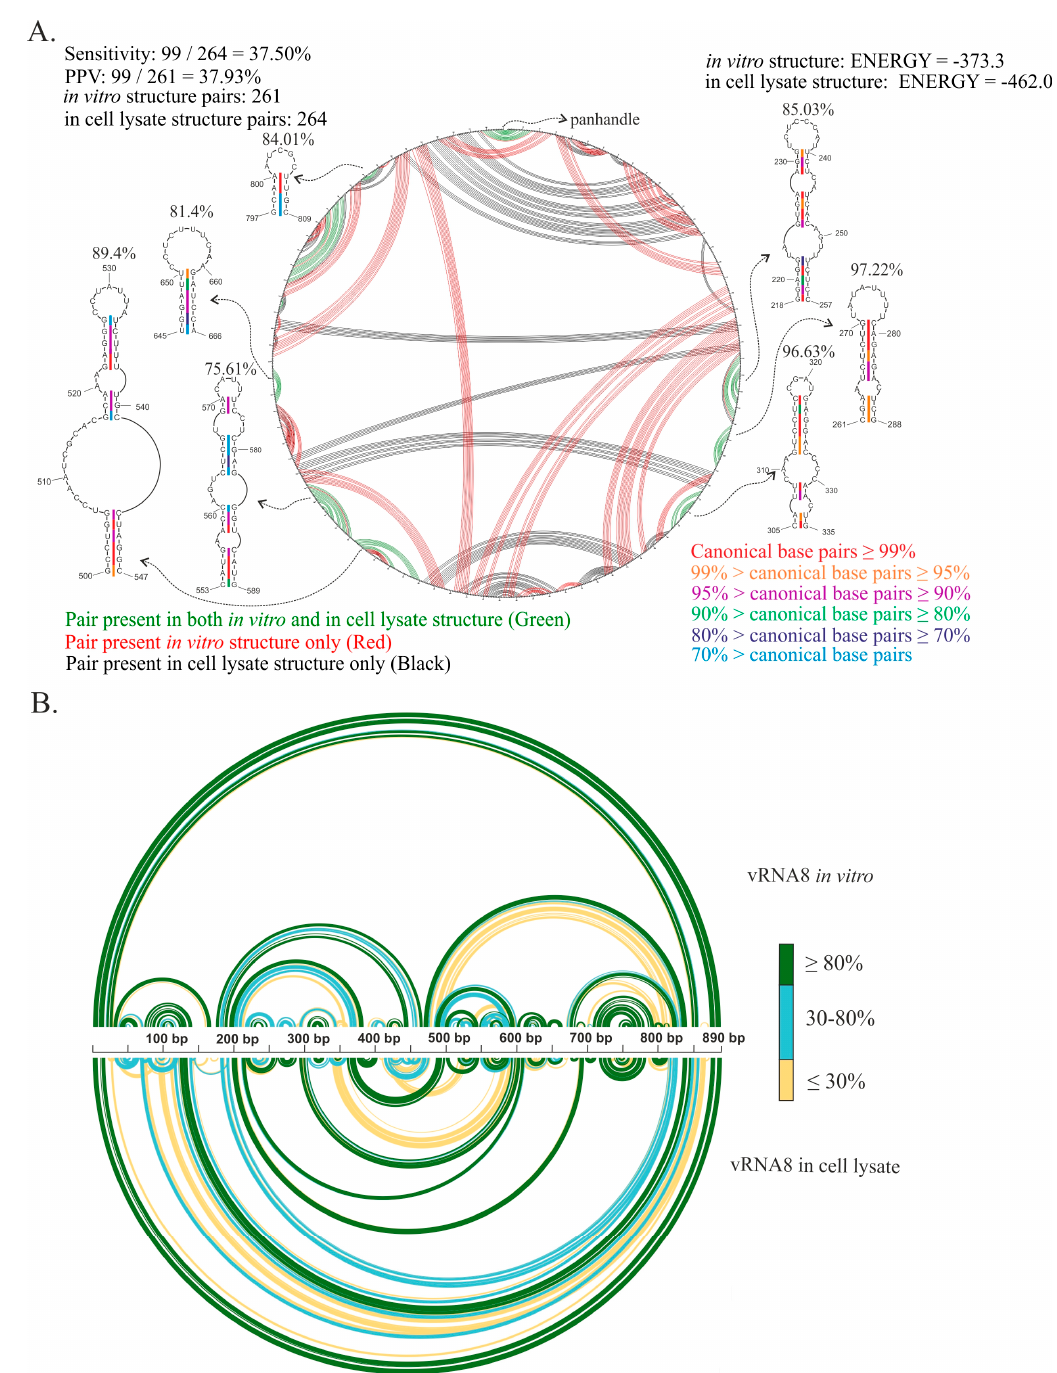
Figure 10. Comparison of vRNA8 A/California/04/2009 structures predicted based on experimental results in vitro and in cell lysates. ( A ) CircleCompare comparison of structures shows differences (red color—pair predicted in vitro, black color—pair predicted in cell lysate) and similarities (green color) in base-pairing of vRNA8 between in vitro and in cell lysate. Low sensitivity and PPV values indicated a low resemblance between the vRNA8 structure probed in different environments. Structural motifs predicted in both environments are shown and the base-pairing conservation according to a color scale and average percentage conservation of each motif is indicated above. ( B ) Comparison of vRNA8 structures predicted in vitro and in cell lysates with the base-pairing probabilities calculated with partition function (RNAstructure). The colors indicate the probability of each base pair in a three-point color